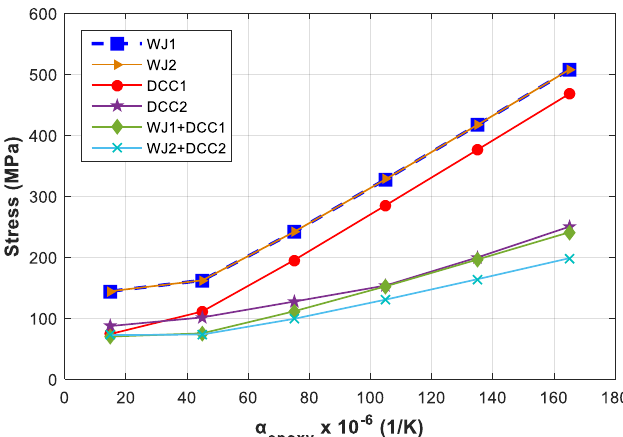
Figure 12. Maximum stress calculated in the copper wires as a function of the coefficient of thermal expansion of epoxy.